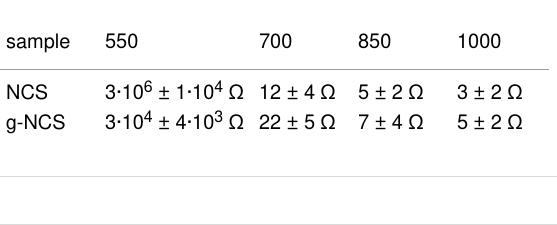
Table 6: ORR onset potentials (potential value at 0.1 mA·cm − 2 ) of the NCS and g-NCS catalysts in the ORR measurements in Figure 8. sample ORR onset potential / V